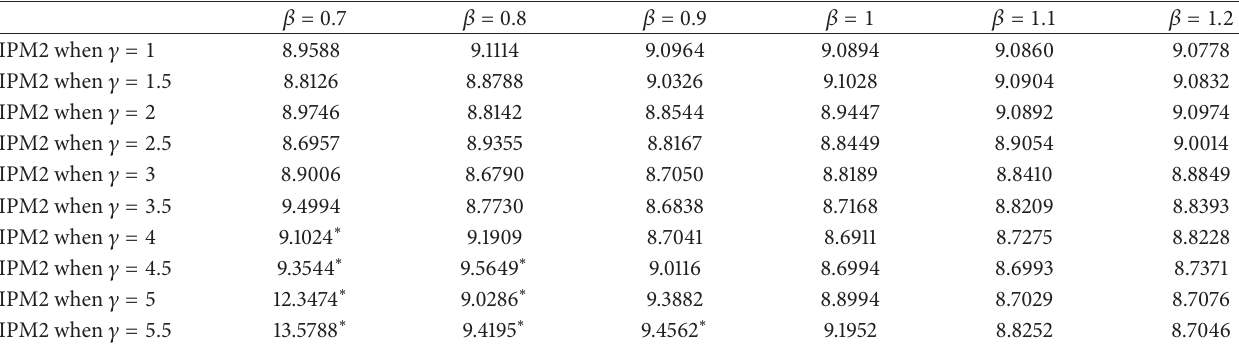
Table 2: Prediction errors of the new improved parsimonious multivariate Markov chain model with the new convergence condition of the new variability in Example